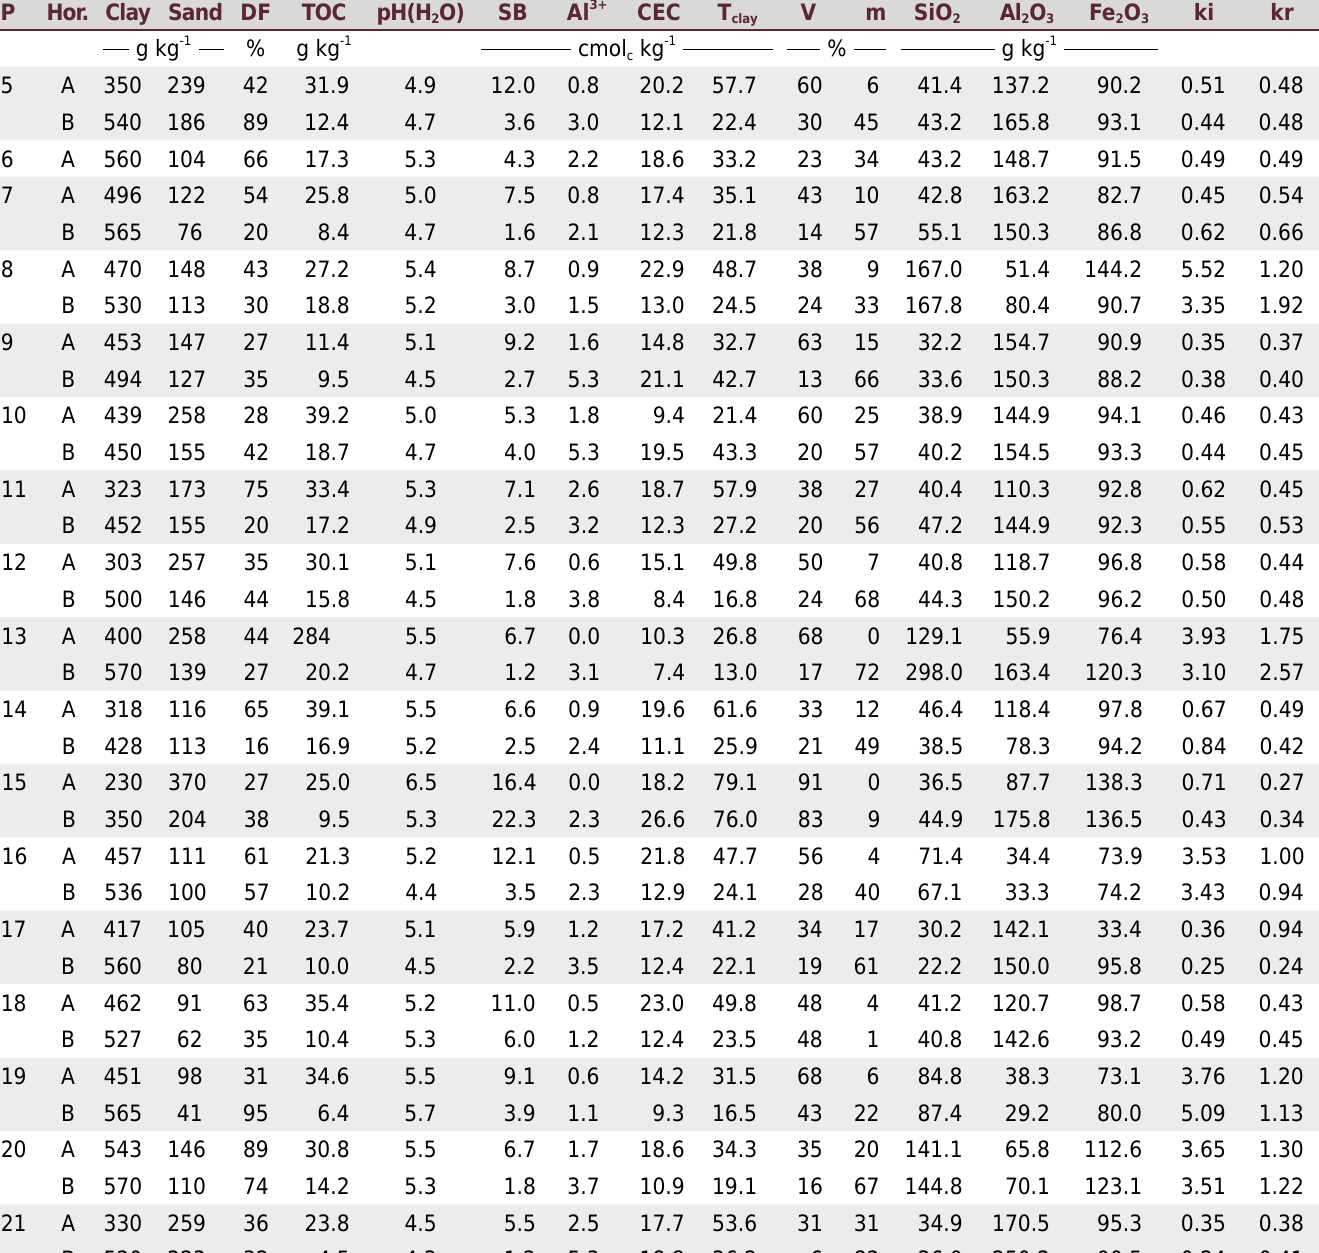
Table 3. Physical and chemical properties of A and B horizons of soil profiles (P) from region II (igneous acidic rocks), located in the municipalities of São Joaquim and Urupema, SC,